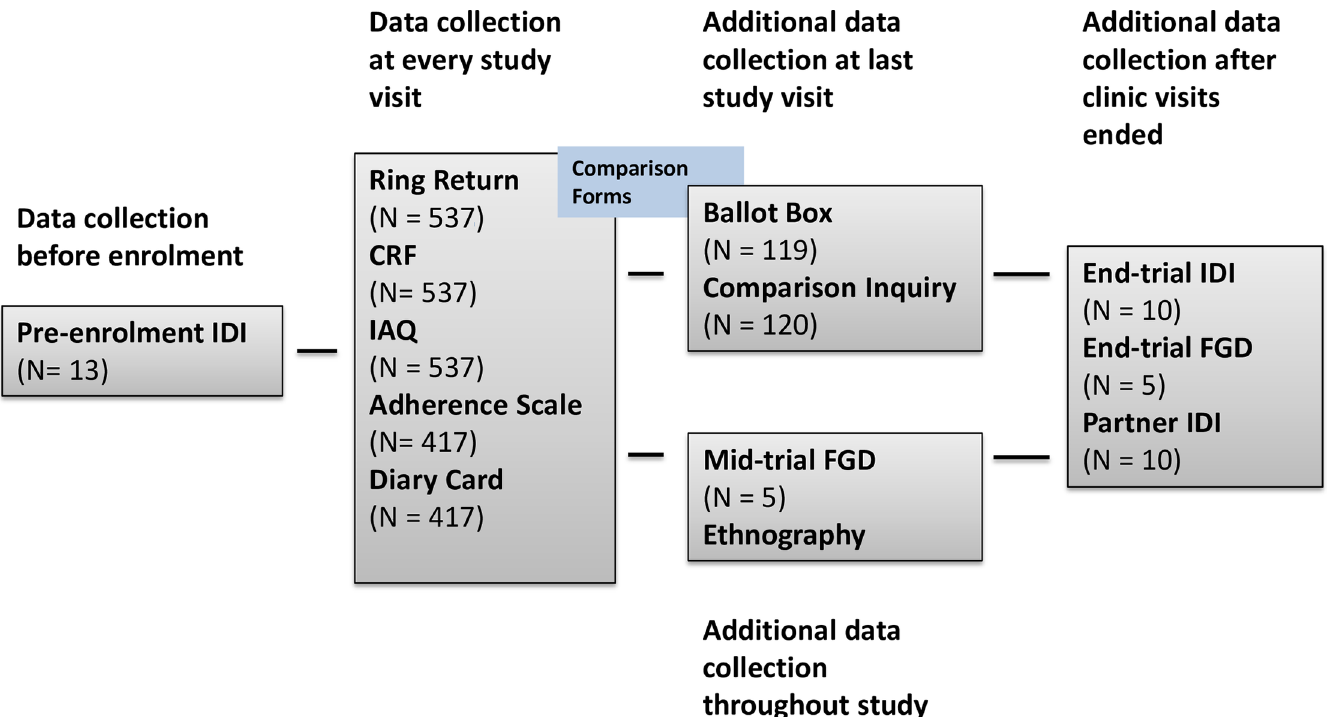
Fig 2. Flow chart of quantitative and qualitative data collection in the Ring Plus study. Quantitative and qualitative data collected before, during and after study end are presented.